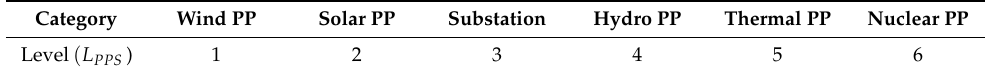
Table 8. Power plants and substations categories (PP—power plant).